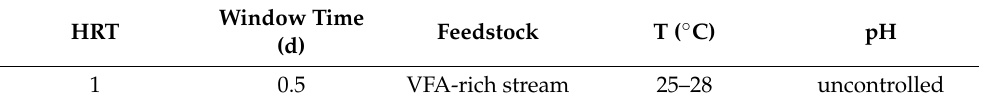
Table 3. SBR operating parameters.